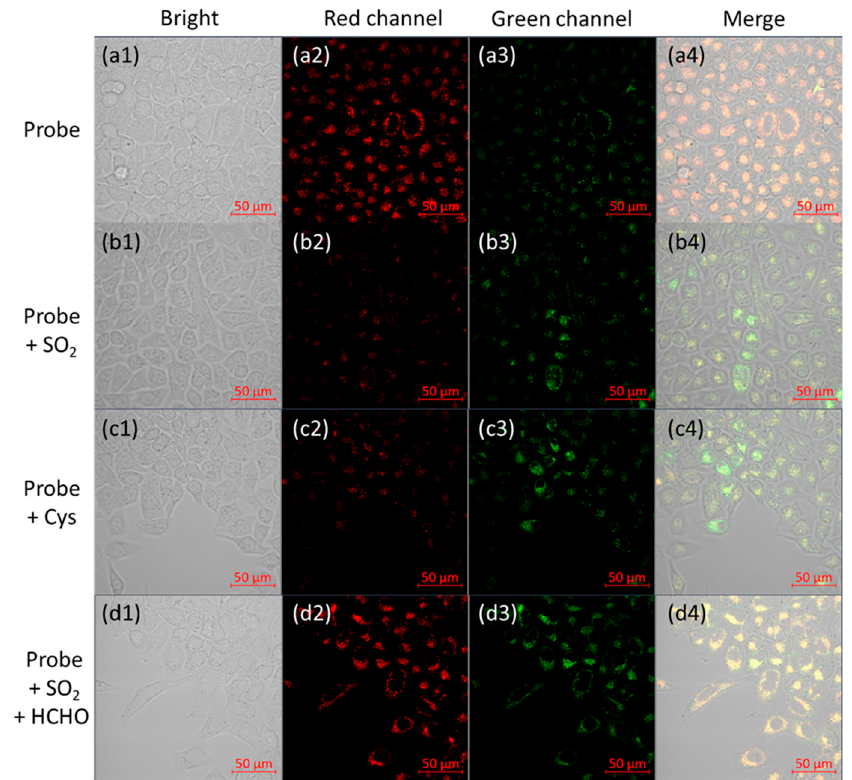
Figure 3. Confocal images of the probe’s responses to endogenous and exogenous SO 2 and HCHO in HeLa tumor strain cells. ( a1 – a4 ) Cells were cultured with 10 μ M B2P for 20 min; ( b1 – b4 ) cells were cultured with 10 μ M B2P for 0.5 h then cultured with 50 μ M of odium bisulfite for 20 min; ( c1 – c4 ) cells were first incubated with 10 μ M B2P for 0.5 h, then incubated with sodium bisulfite (100 μ M) for 20 min; ( d1 – d4 ) probe-loaded cells incubated with sodium bisulfite (50 μ M) for 20 min were then incubated with HCHO (500 μ M) for another 1 h. From left to right: bright field; red channel: λ em = 580–650 nm; green channel: λ em = 480–520 nm; merge. Scale bar, 50 μ m.